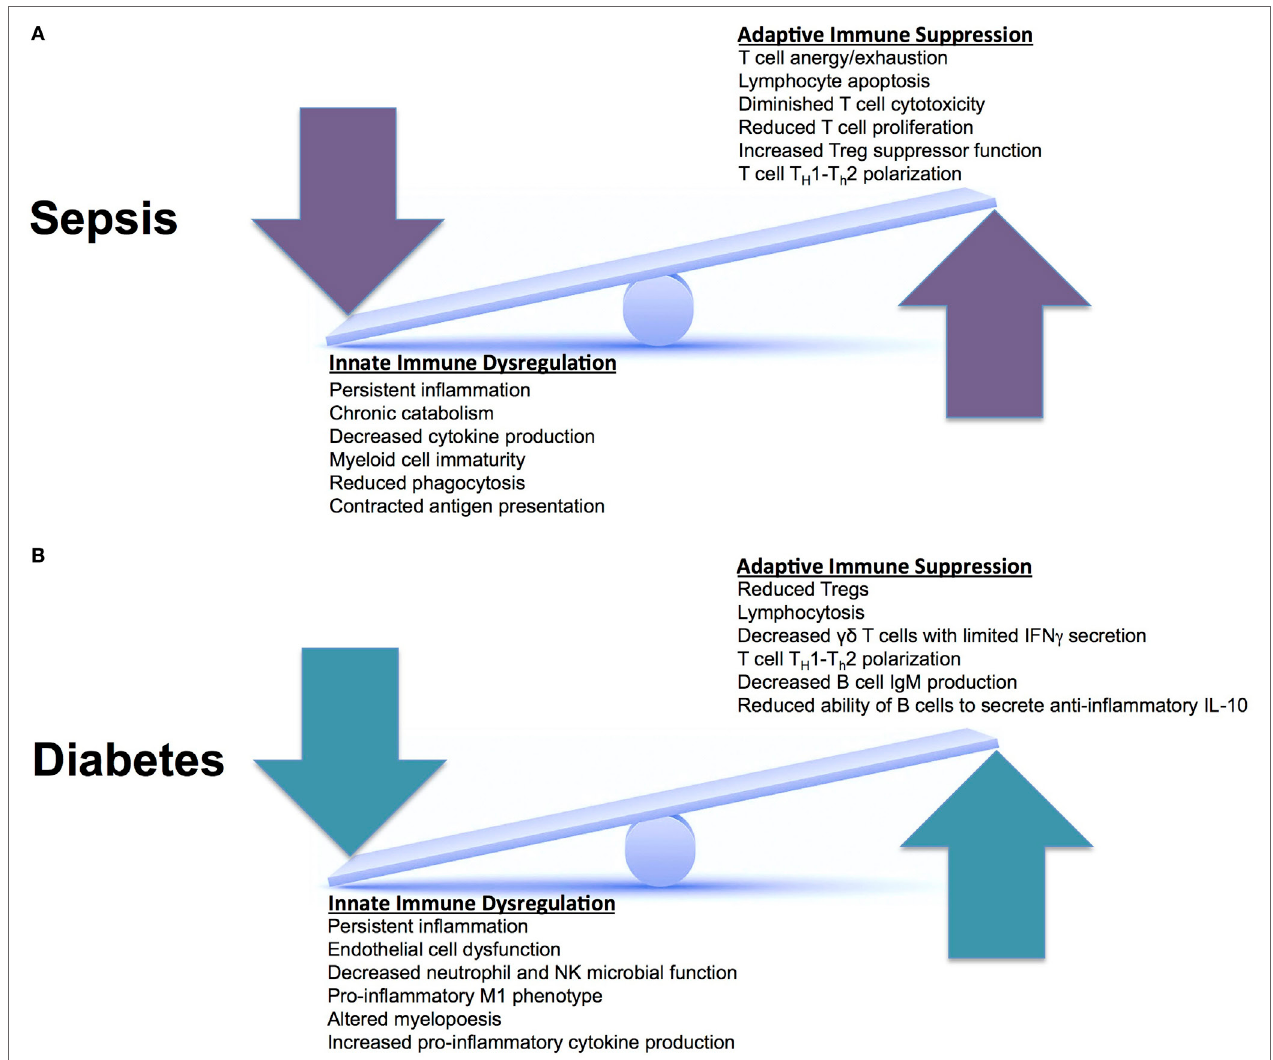
FigURe 2 | Innate versus adaptive immune responses in sepsis and Type II diabetes. (A) During an acute episode of sepsis, the innate and adaptive immune systems are in a constant state of fluctuation. They respond to an invading pathogen and attempt to recover homeostasis after the pathogen is cleared. This continual seesaw effect is thought to drive ongoing inflammation, facilitate organ injury, and enable infectious complications. (B) In diabetes, the innate and adaptive immune systems experience chronic derangements secondary to chronic inflammation, also placing these systems in constant flux. When these two systems (sepsis and diabetes) are superimposed, patients have increased morbidity and mortality; however, we do not know why. There are unclear synergistic versus antagonistic changes occurring that leads to worsened immune system perturbations and the inability to return to